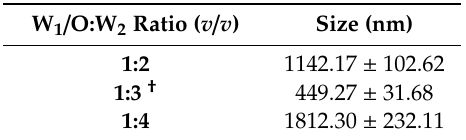
Table 3. E ff ect of W 1 / O:W 2 ratio ( v / v ) on droplet size of double emulsion (at 25 ◦ C, n = 3, mean ± SD). W 1 / O:W 2 Ratio ( v / v ) Size (nm) 1142.17 ± 102.62